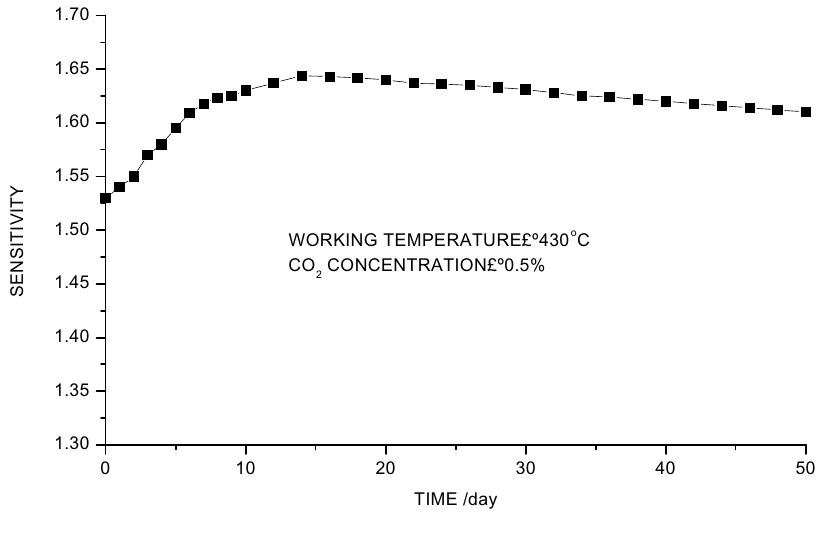
based CO sensor. 3 2